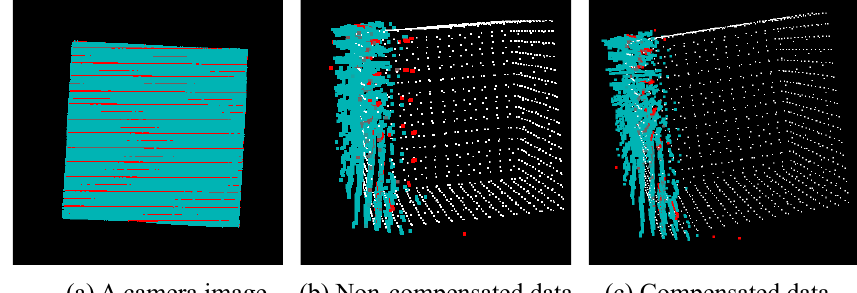
Figure 21. Correction of spatial